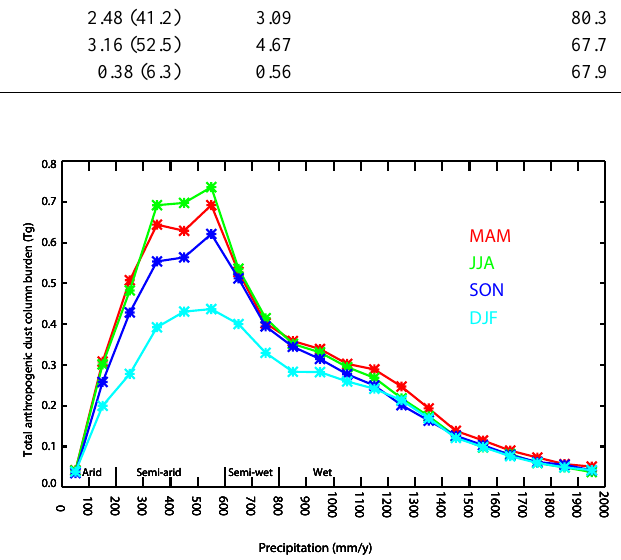
Figure 8. Comparisons of dust column burden as function of cli- matological mean precipitation for different four seasons (spring, summer, autumn, and winter) of global anthropogenic land cover. The precipitation interval is 100mmyr − 1